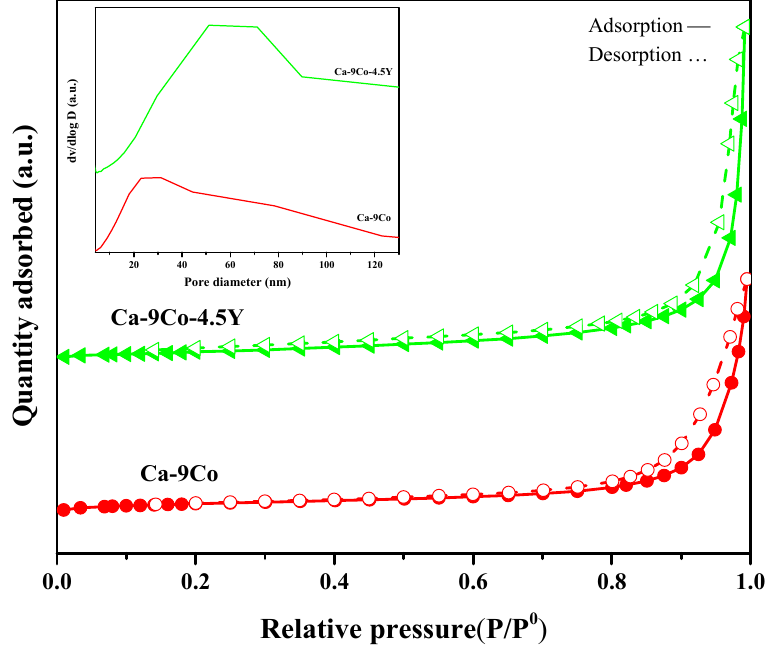
Figure 4. N 2 adsorption/desorption isotherms and pore size distributions of fresh samples.